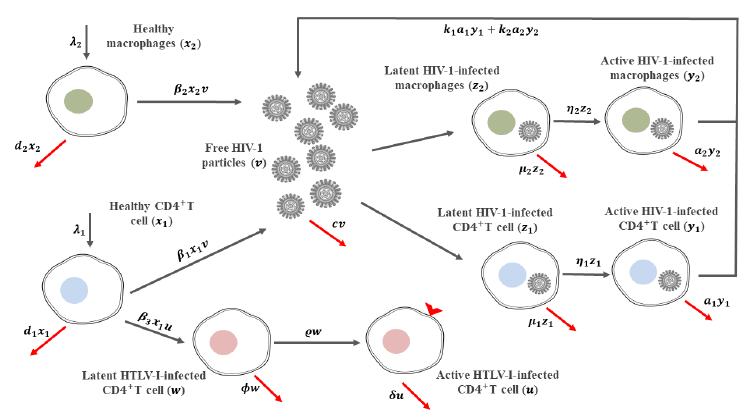
Figure 1. Scheme of the HTLV-I and HIV1 coinfection